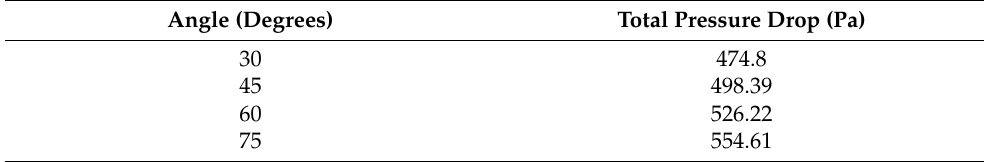
Table 1. Total pressure drops experienced by blood, based on anastomosis angle.